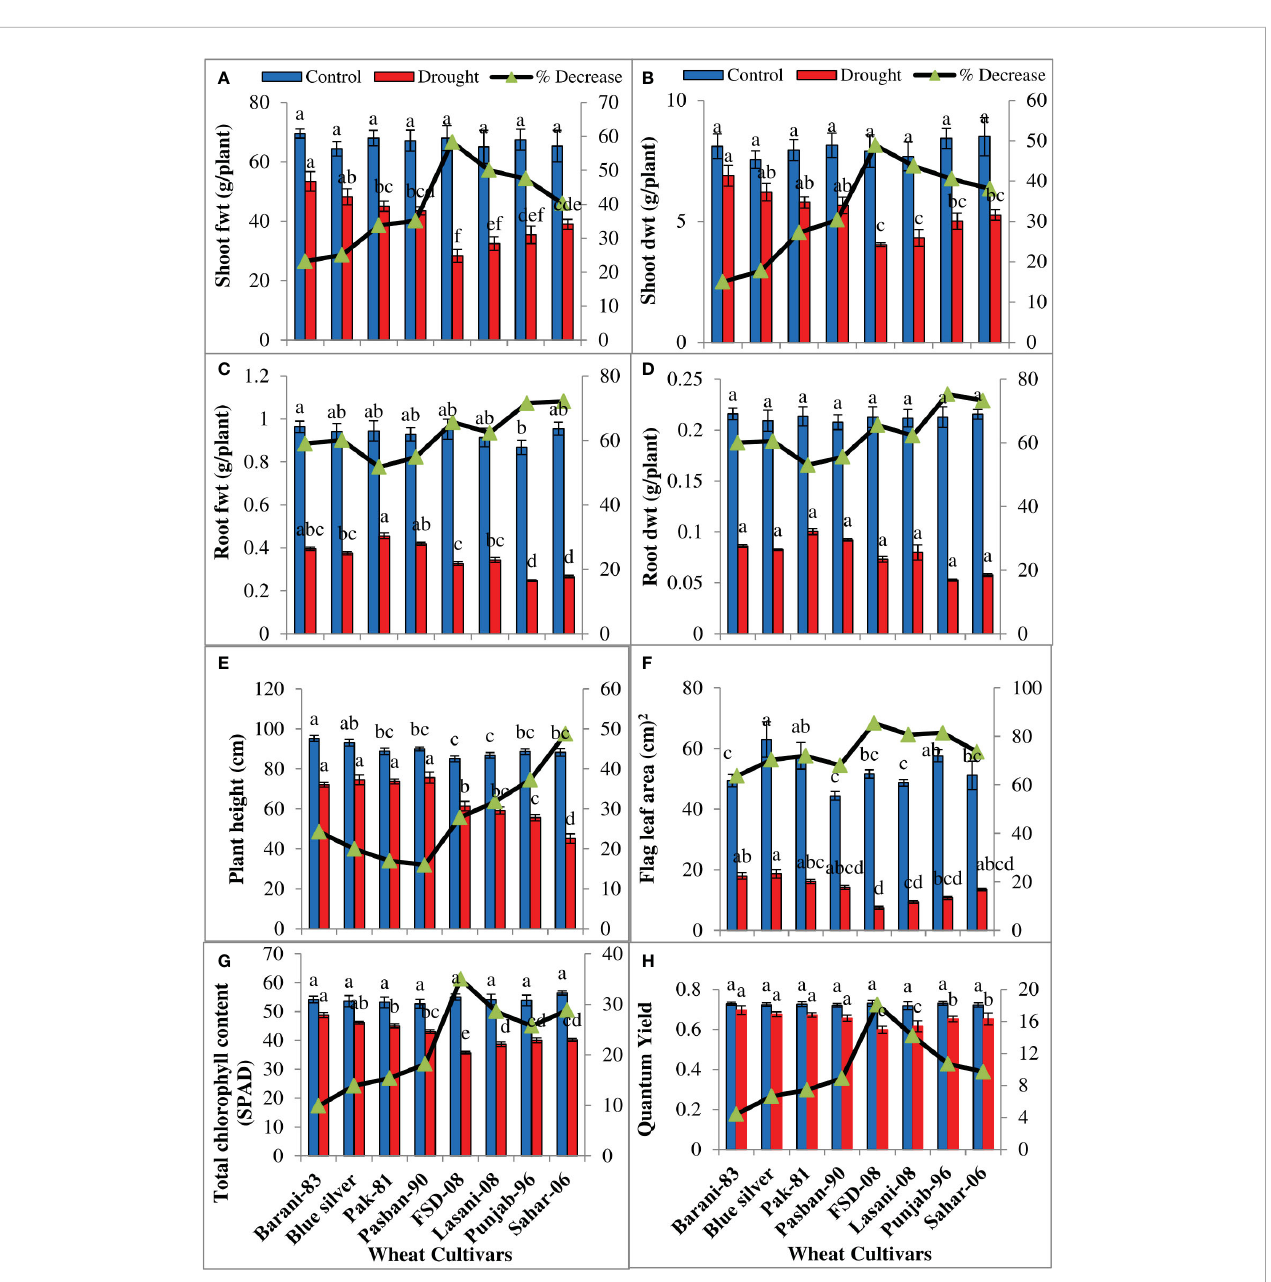
FIGURE 3 Growth attributes of selected wheat cultivars subjected to control or drought stress at adult stage. Means (± SE; n=5) are presented on the primary vertical axis, while percent decrease value is presented on the secondary vertical axis. Different letters represent signi fi cant differences among cultivars at p < 0.05 according to LSD test. (A) Shoot fresh weight, (B) shoot dry weight, (C) root fresh weight, (D) root dry weight, (E) plant height, (F) fl ag leaf area, (G) total chlorophyll content (SPAD), and (H) quantum yield of